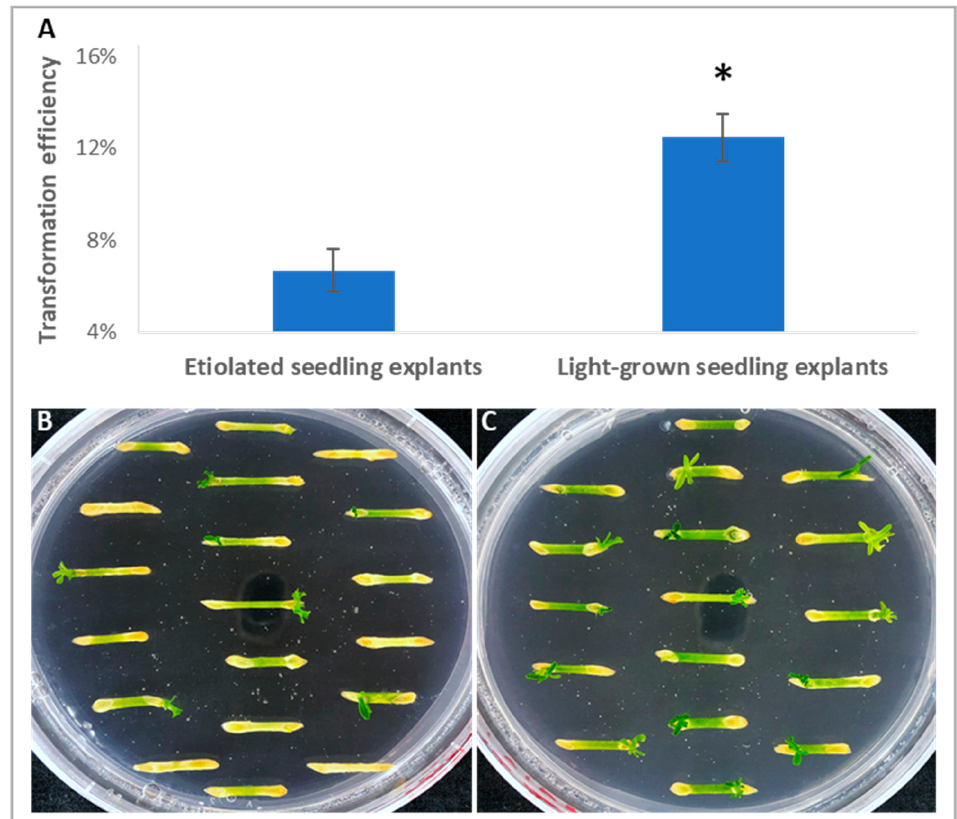
Figure 1. Light-grown explants of ‘Carrizo’ citrange had higher transformation efficiency compared with etiolated explants. ( A ) Higher transformation efficiency was observed with light-grown epicotyl explants compared with etiolated epicotyl explants. Asterisk represents significant difference between etiolated seedling explants and light-grown seedling explants ( p < 0.05, ANOVA). ( B , C ) Shoots regeneration from epicotyl explants derived from etiolated seedlings ( B ), and from those of light-grown seedlings ( C ) at day 30th post- Agrobacterium -infection (dpi).